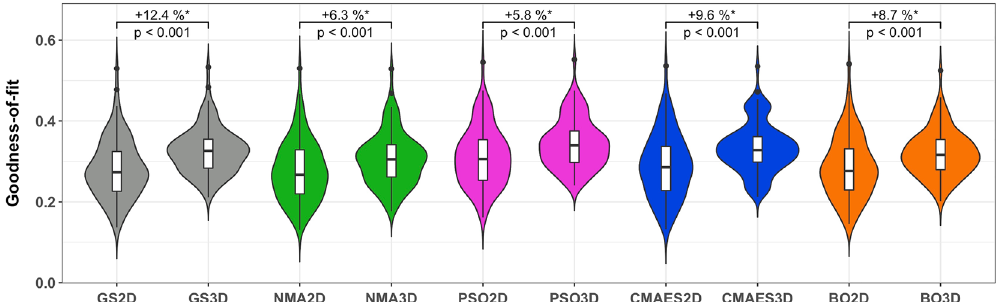
Figure 3. Distributions of the goodness-of-fit values for all tested approaches and dimensionalities. The considered methods and the respective parameter space’s dimension are indicated on the horizontal axis (GS2D, NMA2D, PSO2D, CMAES2D, BO2D in 2Dim and GS3D, NMA3D, PSO3D, CMAES3D, BO3D in 3Dim) along with the detected goodness-of-fit values on the vertical axis. Violins show the distributions of the highest model fit detected for all subjects. The medians (across subjects) of the relative increase between the results in 2Dim and 3Dim are indicated in the plots together with p -values of the Wilcoxon signed-rank test. Statistically significant differences are marked with an asterisk (the significance level of 5%, p < 0.05, has been Bonferroni- corrected for multiple